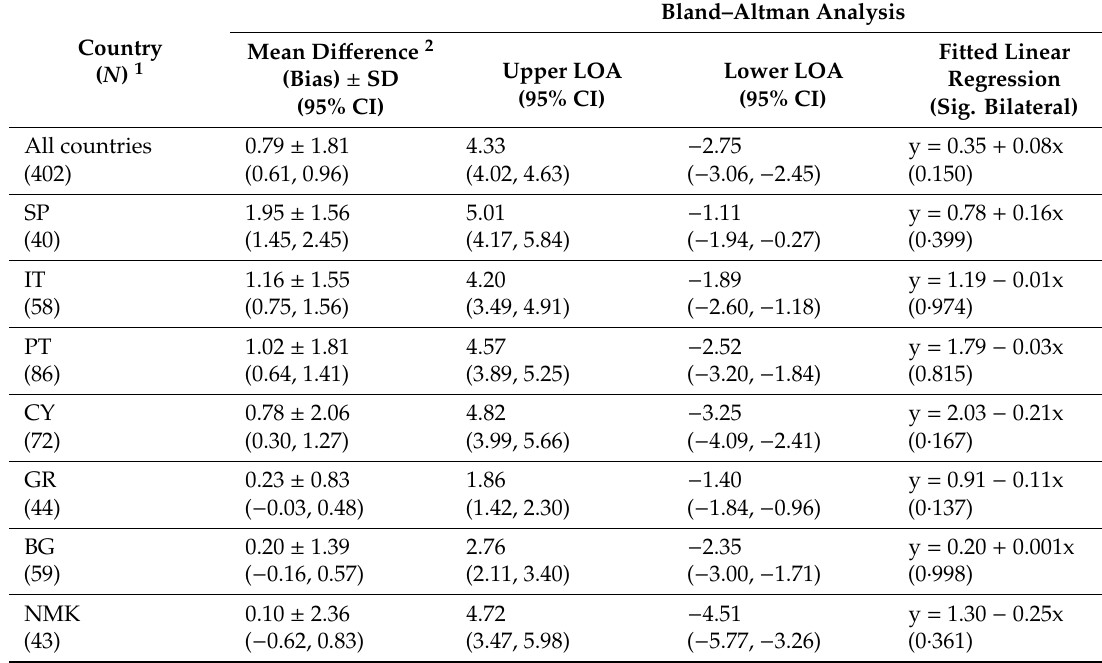
Table 4. Bland–Altman Analysis of the FFQ-MEDAS vs.